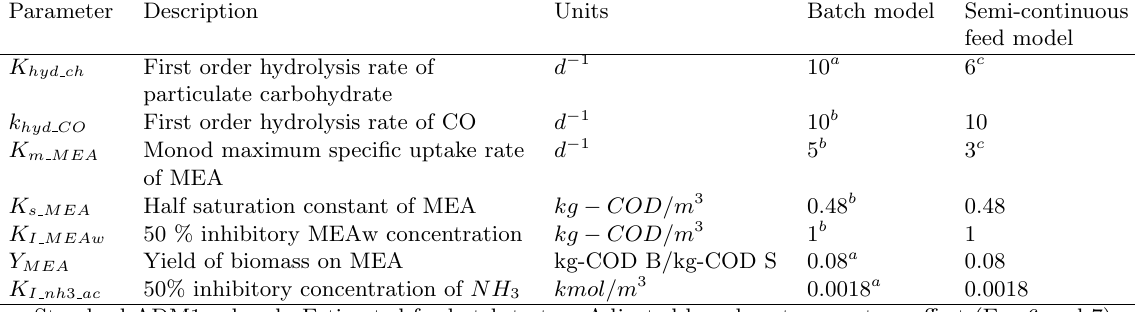
Table 4: Parameters value